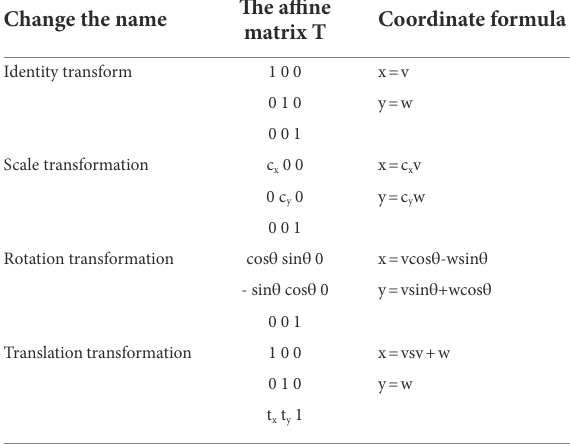
TABLE 4 Principle of affine transformation